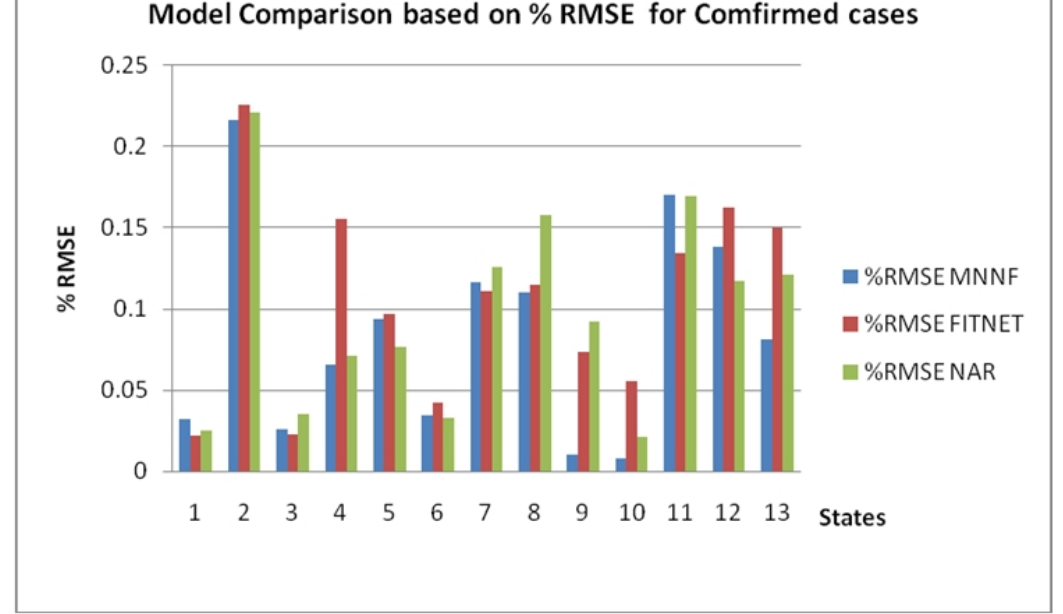
Figure 8. Comparison of % RMSE in confirmed cases for the different models of ANN for the 12 states. Table 2. Example of % RMSE for the different models for the confirmed cases.